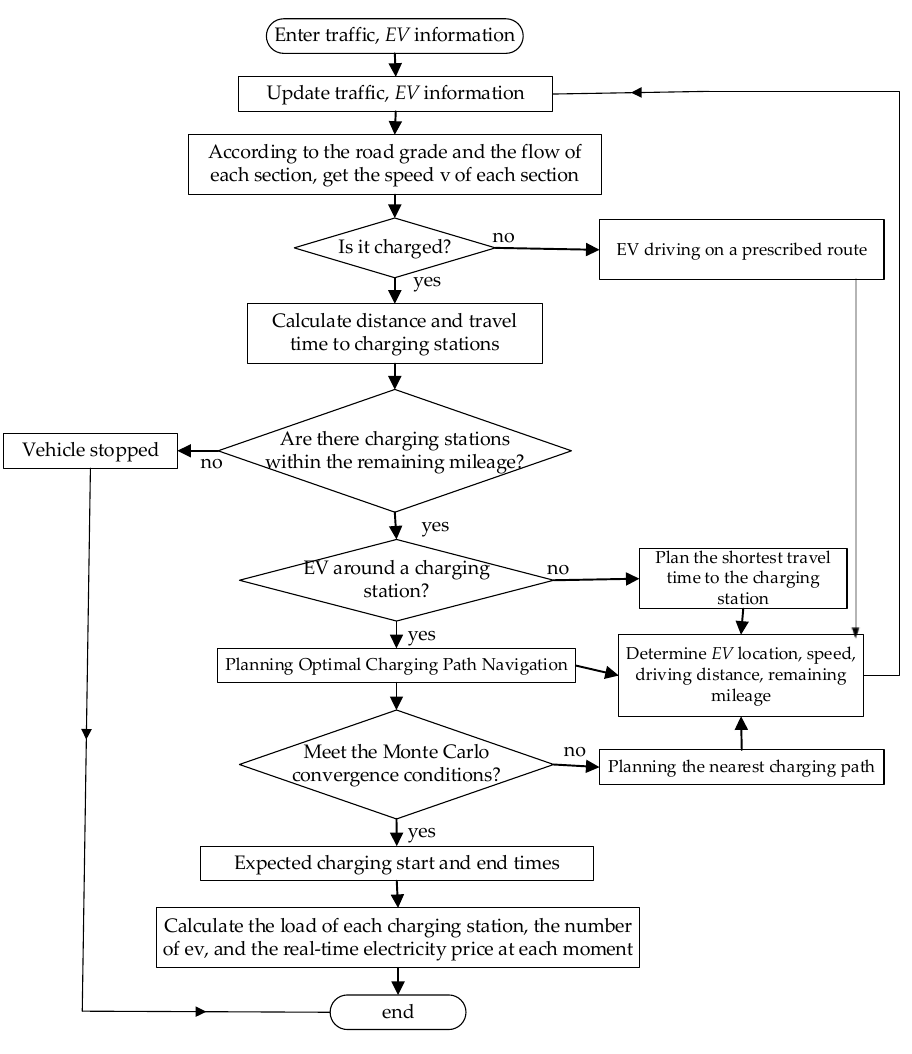
Figure 3. Charging path navigation diagram.